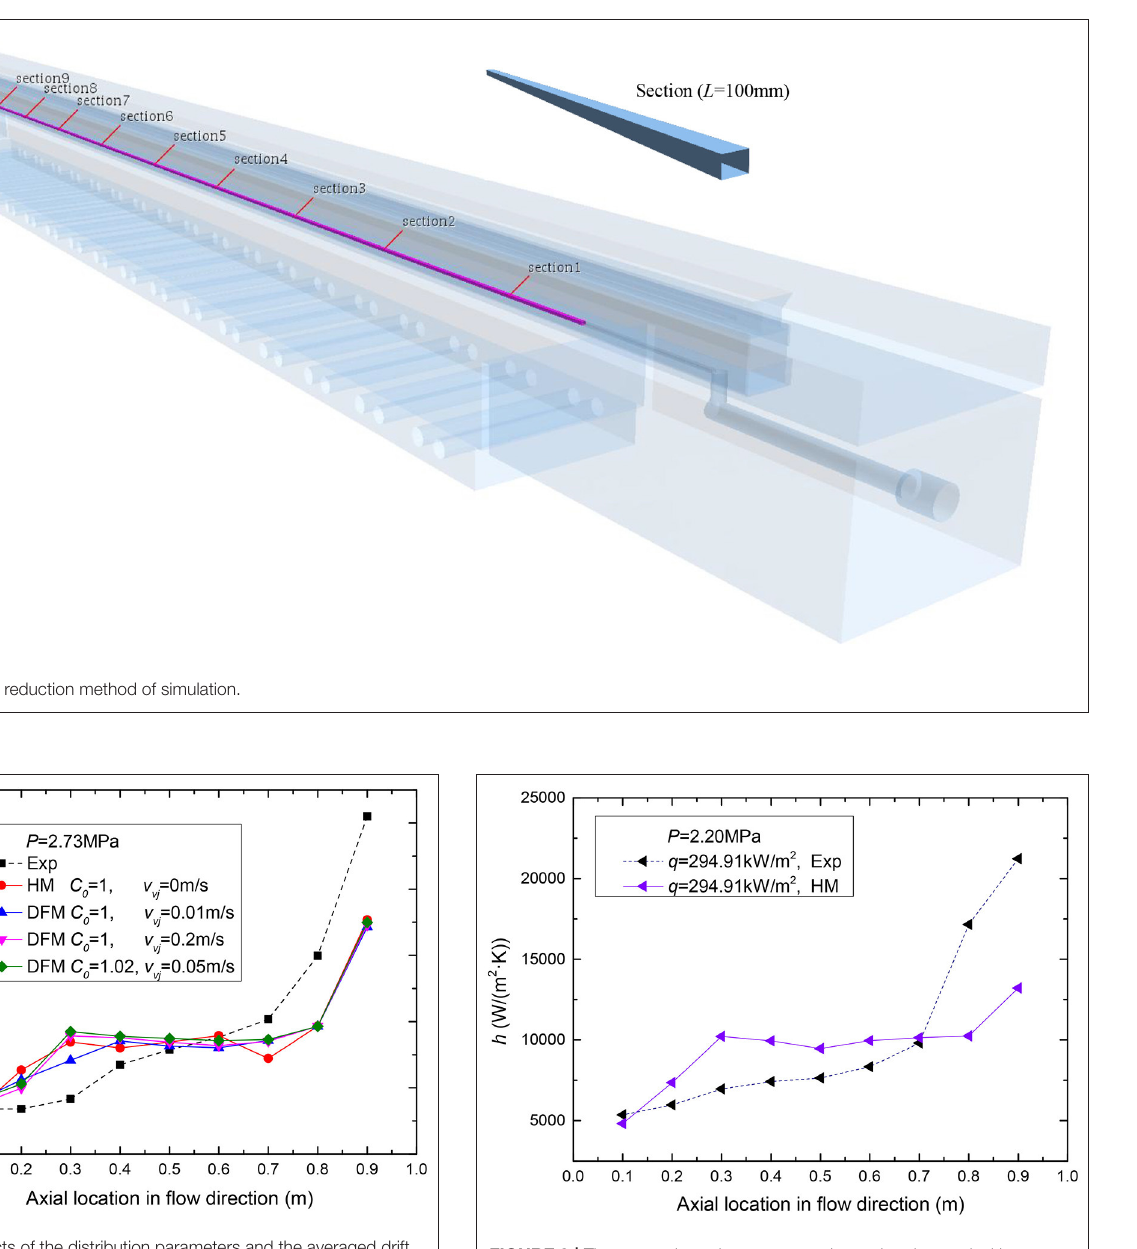
397.36 kW/m 2 , a mass flux of 500 kg/(m 2 · s) are shown in